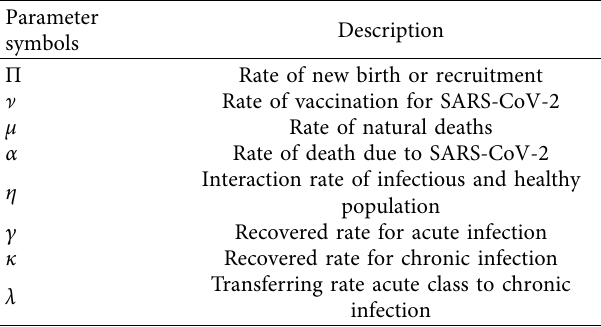
Table 1: The description of different parameters given in model